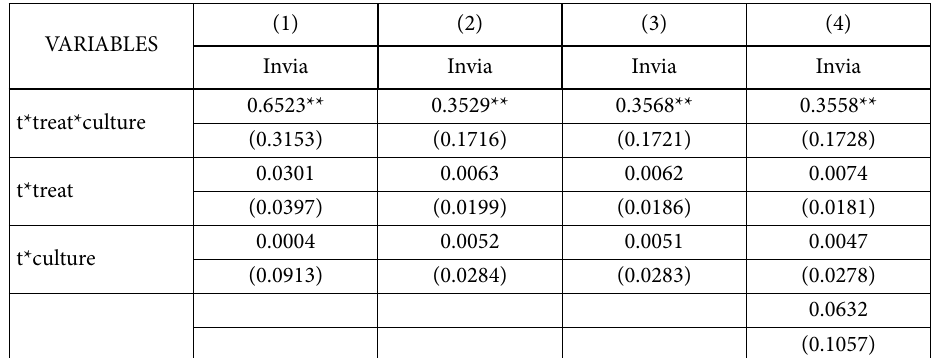
Table 12. Robustness